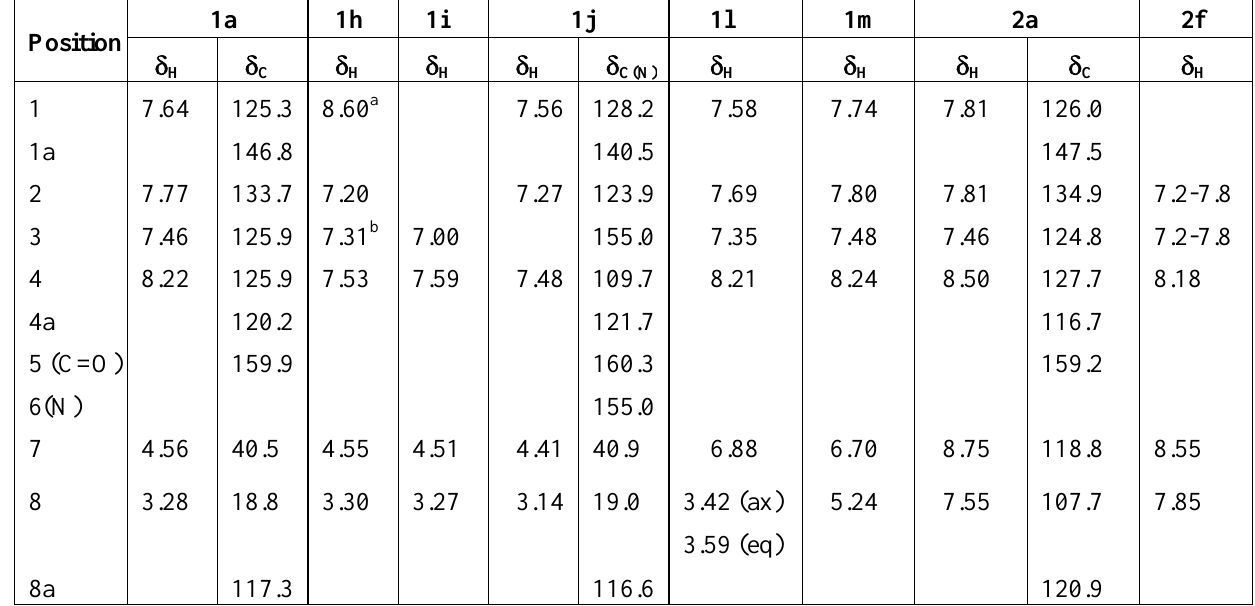
Table 5 . 1 H- and 13 C-NMR assignments for rutaecarpine